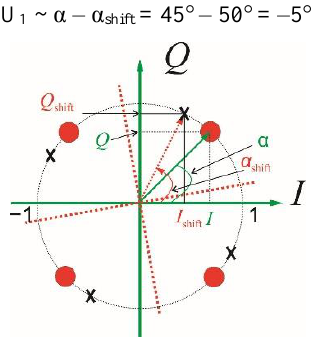
Fig. 7. Example of calculation of the required angle of the signal constellation phase shift compensation of the received